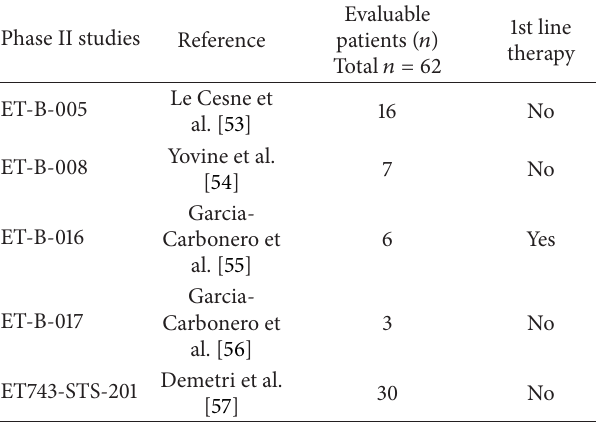
Table 3: Patients included in pooled analysis of five phase II